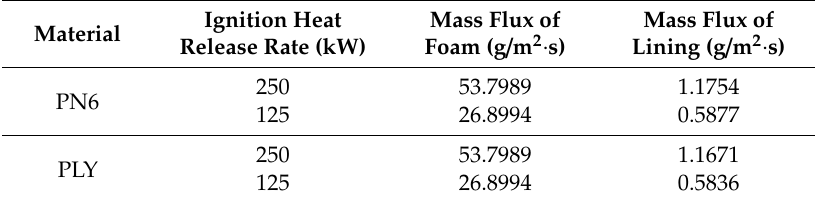
Table 4. Proportional mass flux split per material.